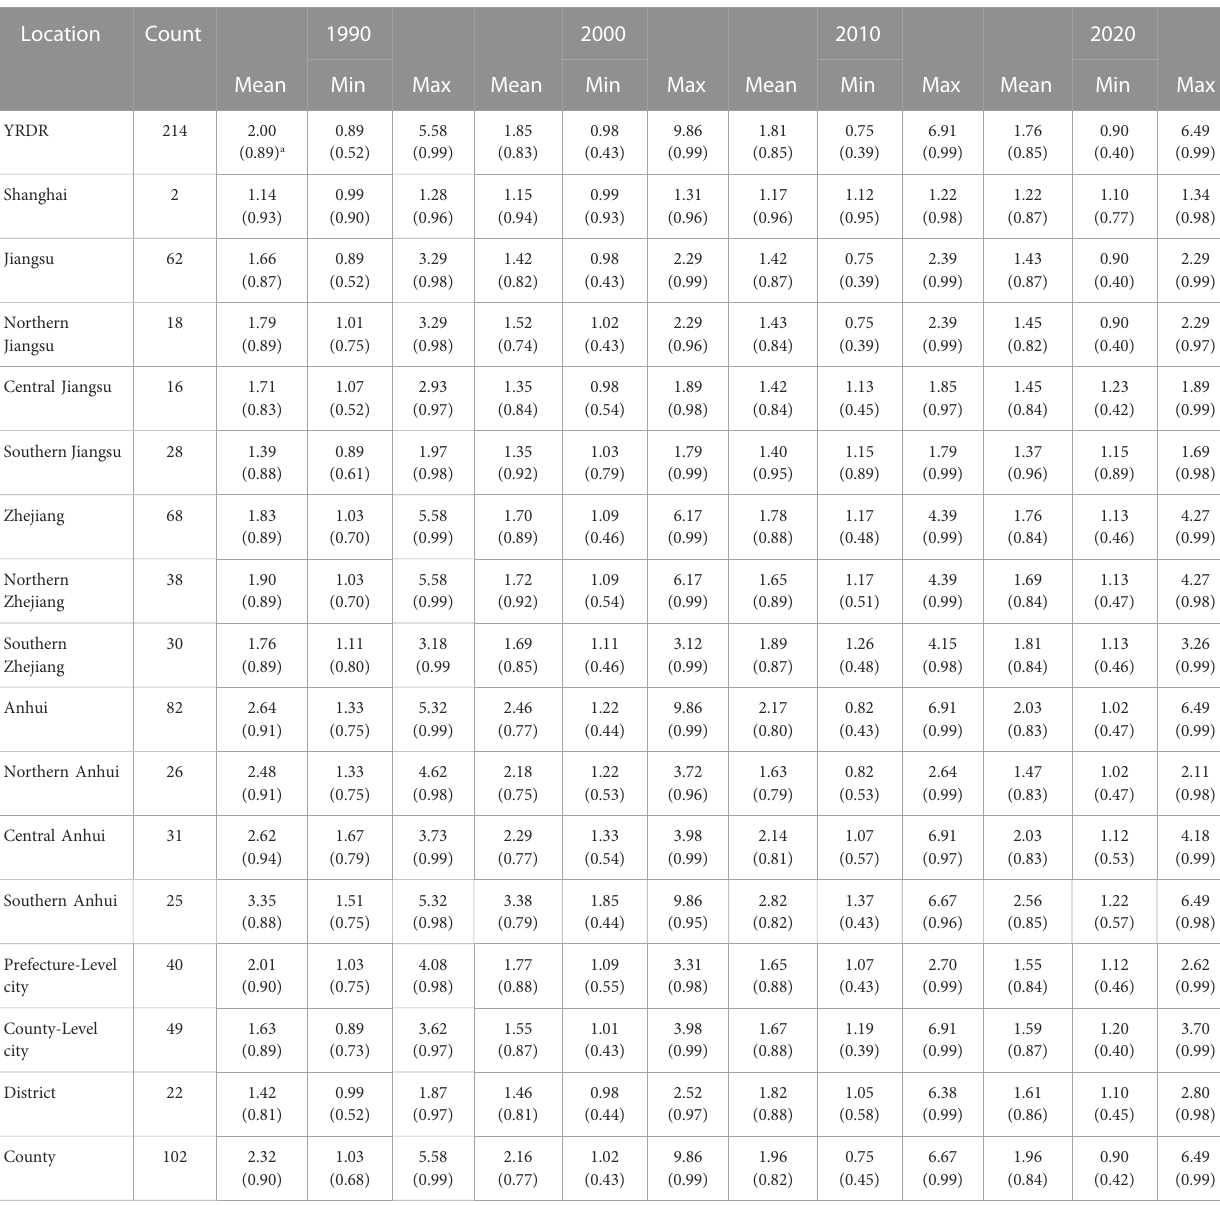
TABLE 2 Descriptive statistics of intra city-size distribution of